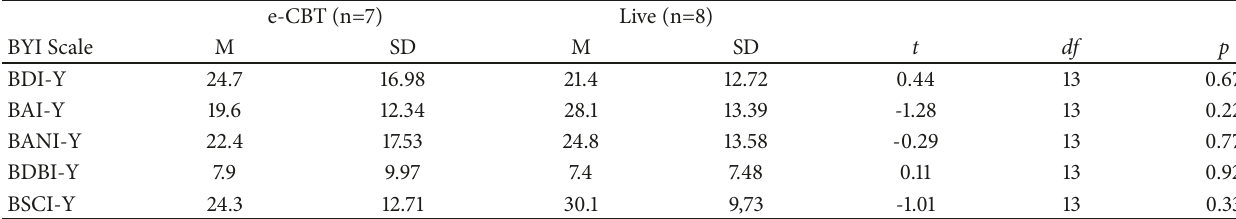
Table 2: Group difference in BYI scales before receiving any